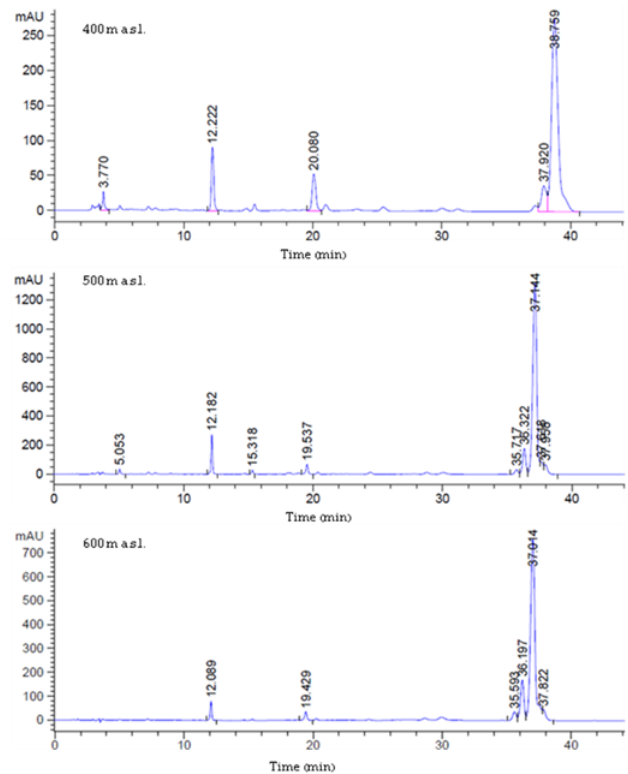
Figure 13 The example HPLC chromatogram of the β -carotene content of T. rigidula at three sampling points in winter season. Retention time of violaxanthin peak in 3–4 min, canthaxanthin peak in 10–12 min, chlorophyll b peak in19–21 min, and β -carotene peak in 35–39